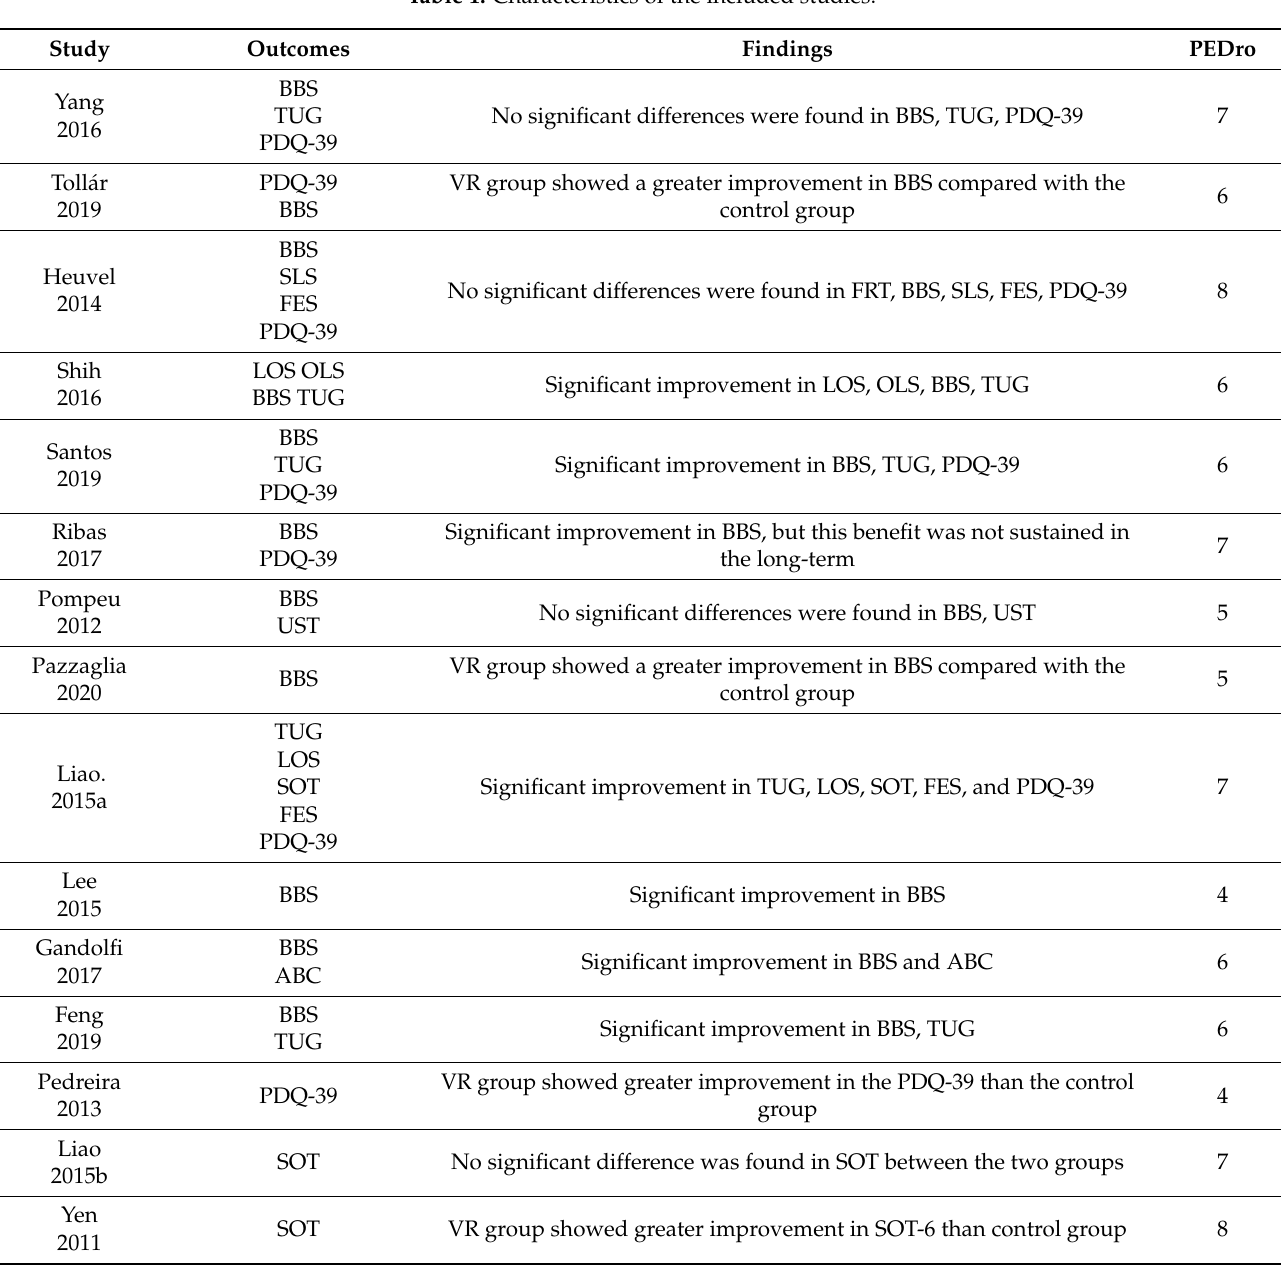
Table 1. Characteristics of the included